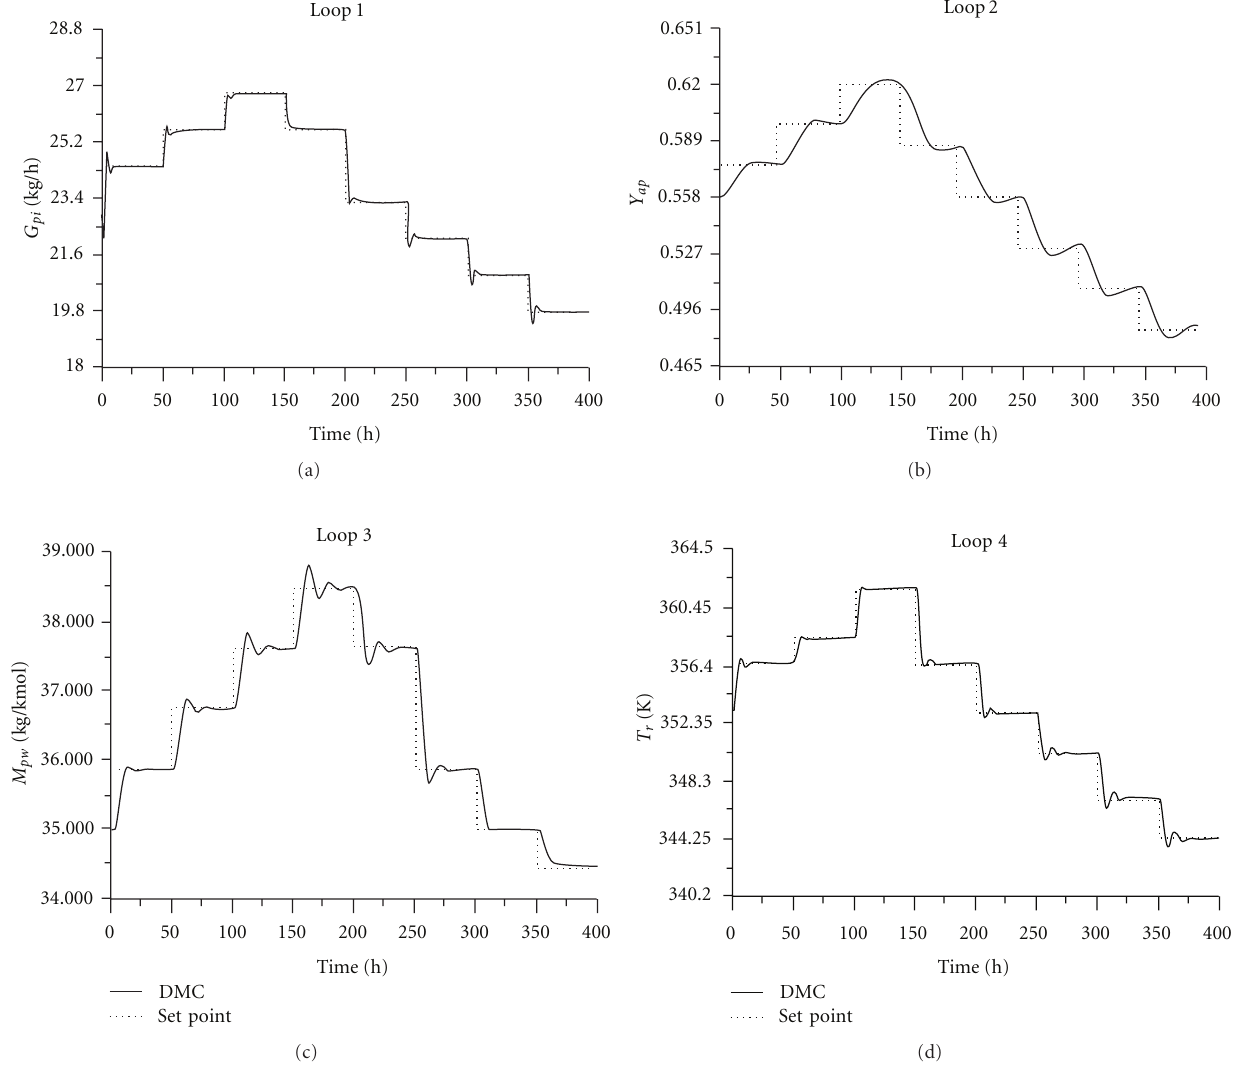
Figure 7: Closed-loop simulations for changes in set